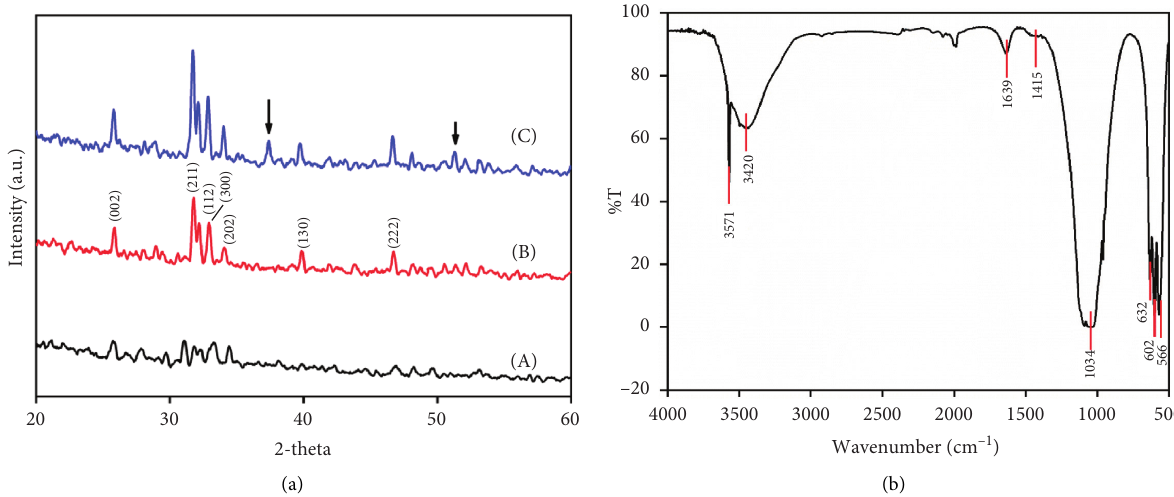
Figure 9: (a) X-ray diffraction patterns of hydroxyapatite powders calcined at different temperatures: (A) 500 ° C; (B) 900 ° C; (C) 1100 ° C. (b) FT-IR spectrum of hydroxyapatite powders calcined at 900 ° C.